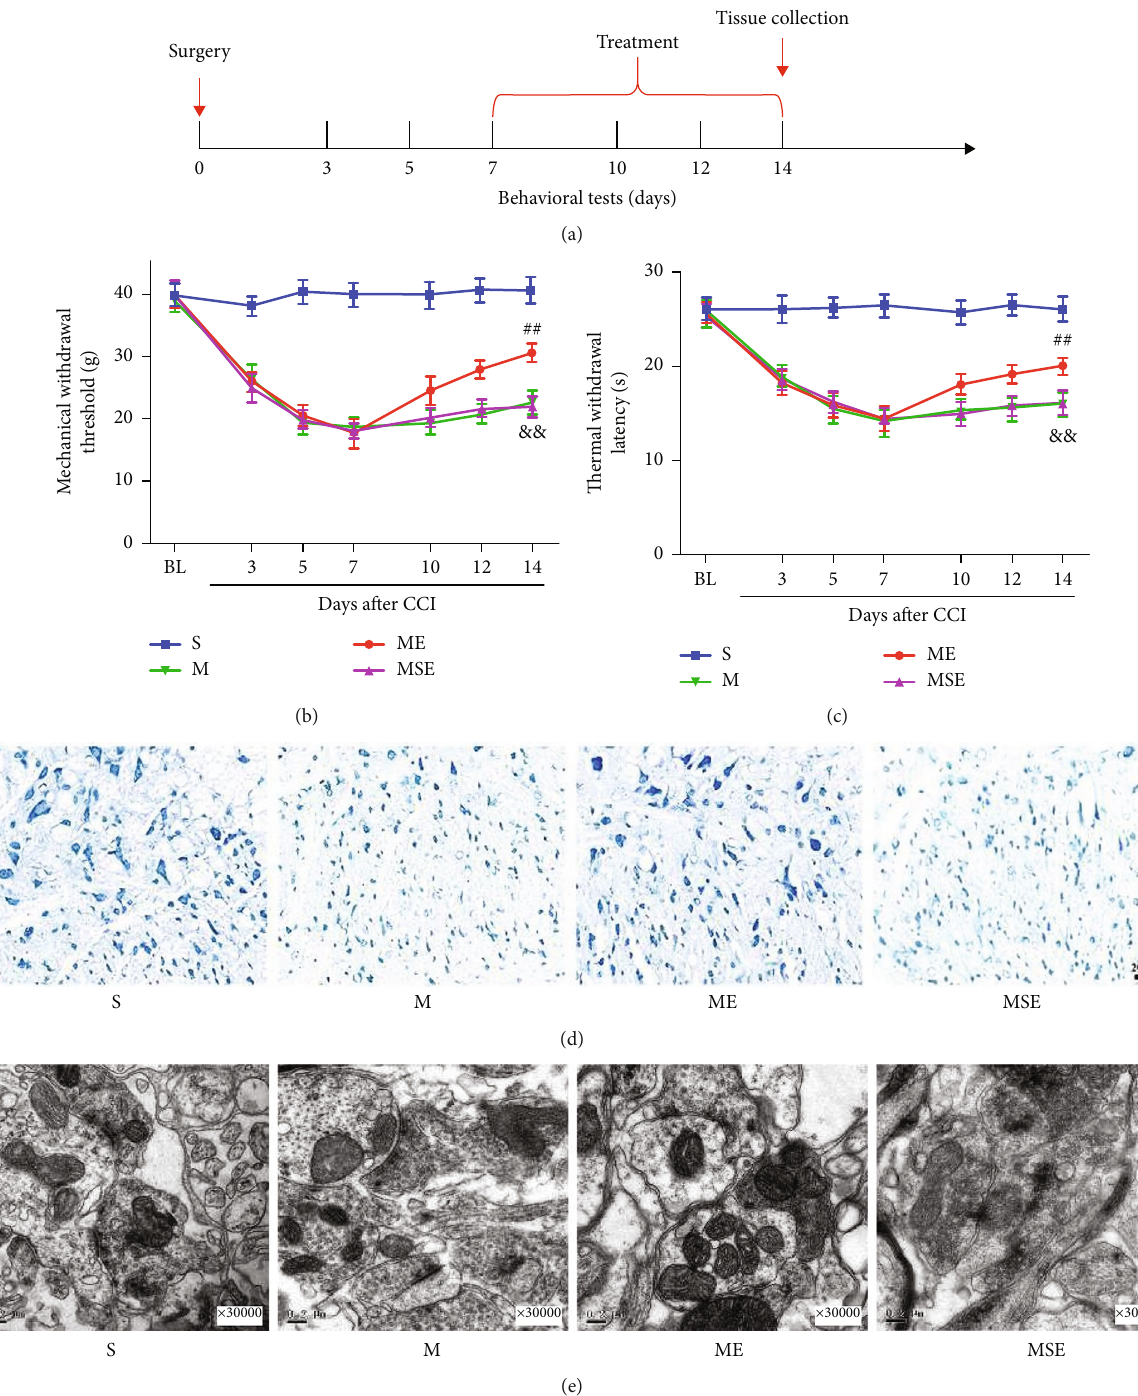
Figure 1: EA treatment alleviated hyperalgesia, reduced nerve damage, and improved synaptic plasticity in CCI rats. (a) Experimental design and timeline. (b, c) Changes in neurobehavioral MWT and TWL values of rats in each group ( n = 14 ). (d) Nissl staining to observe the neuron morphology of the spinal dorsal horn (scale bars: 20 μ m, 50x). (e) TEM to observe the ultrastructural changes at dorsal horn synapses (0.2 μ m, 30000x). && p < 0 : 01 versus S group; ## p < 0 : 01 versus M